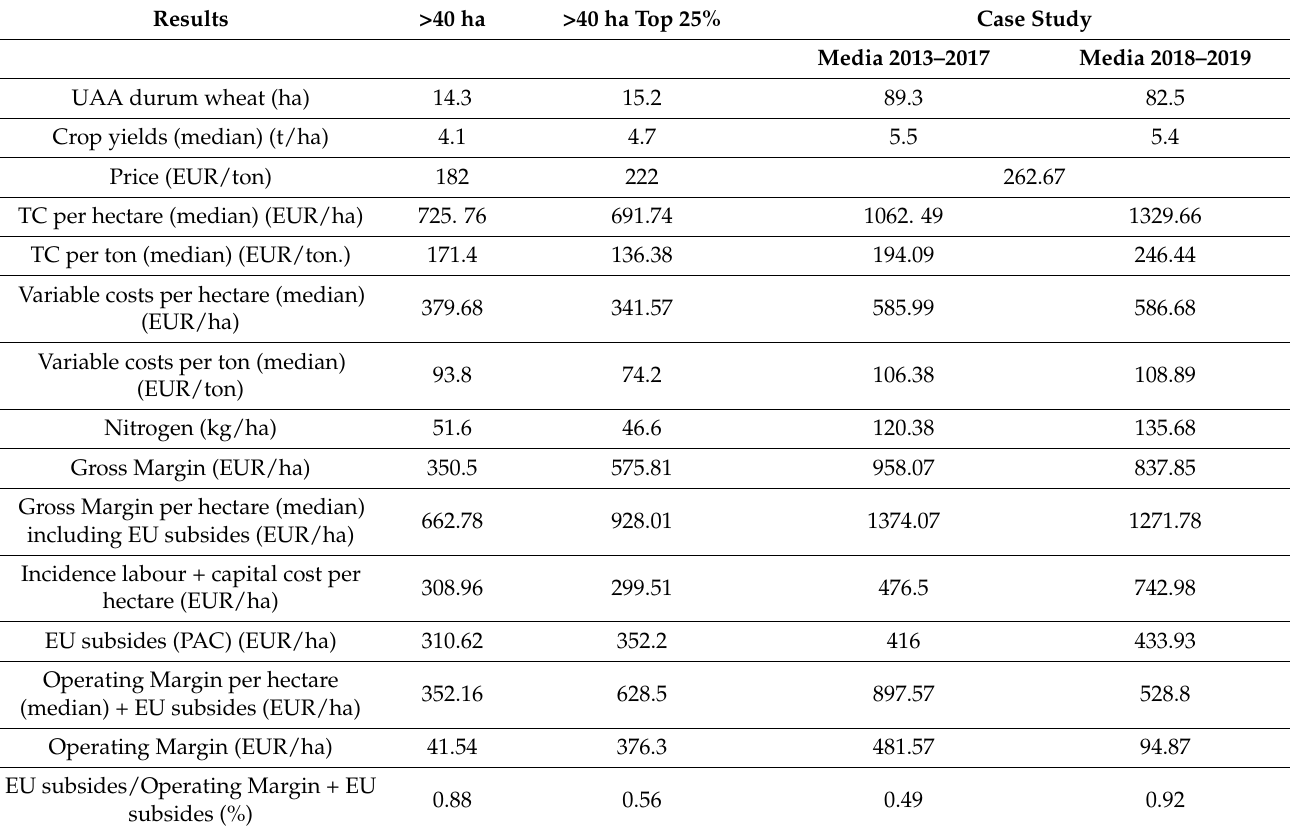
Table 3. Comparison with FADN